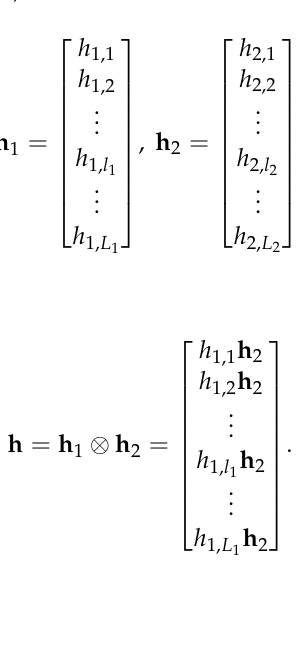
Figure 5. SISO system in cascaded